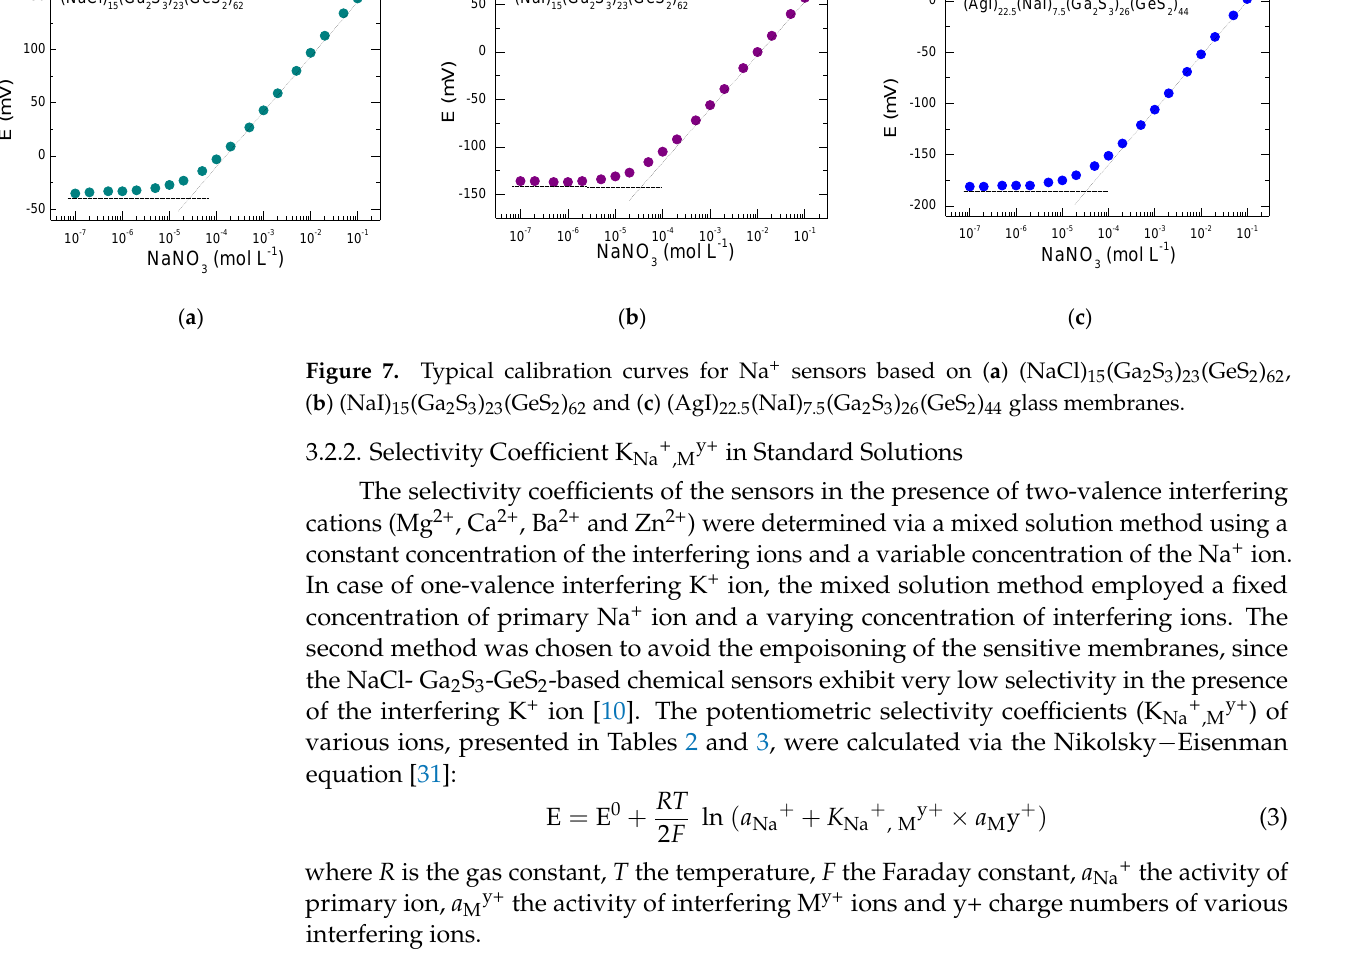
Figure 6. ( a ) Room- temperature conductivity σ 25 and ( b ) conductivity activation energy E σ for the (AgI) x (NaI) 30 − x (Ga 2 S 3 ) 26 (GeS 2 ) 44 glasses plotted as a function of the silver fraction r = Ag/(Na + Ag). The solid lines are drawn as a guide for the eye.